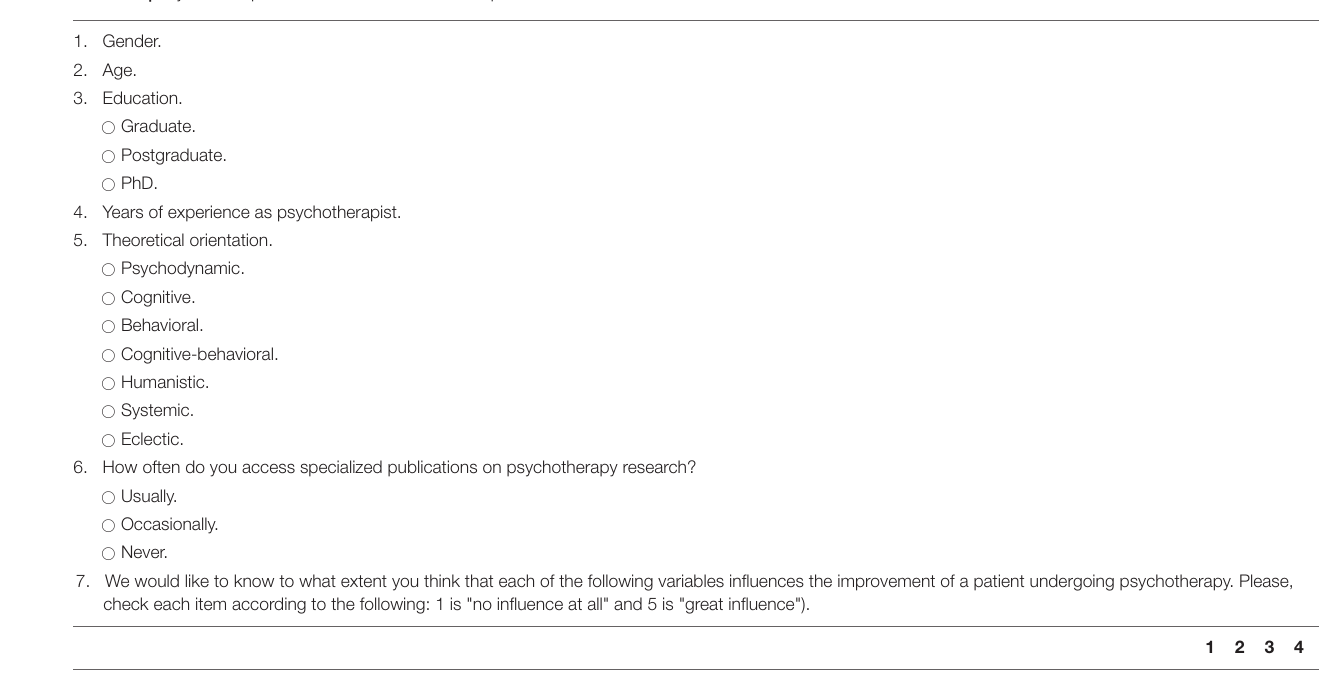
TABLE 1 | Psychotherapeutic effectiveness attribution